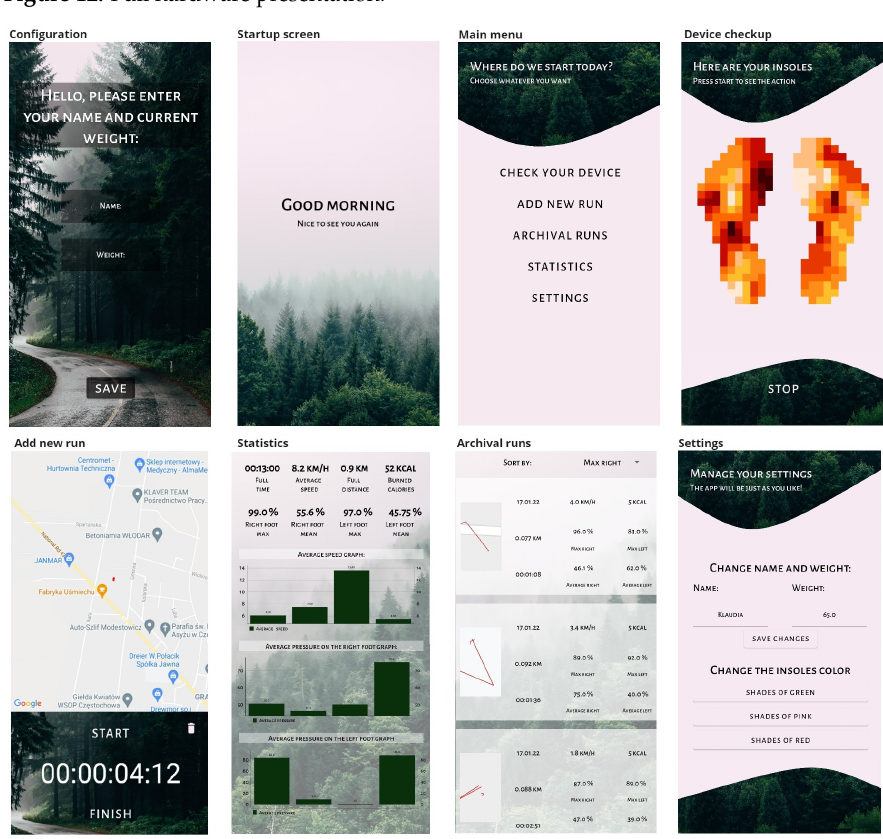
Figure 13. Screenshots of our mobile